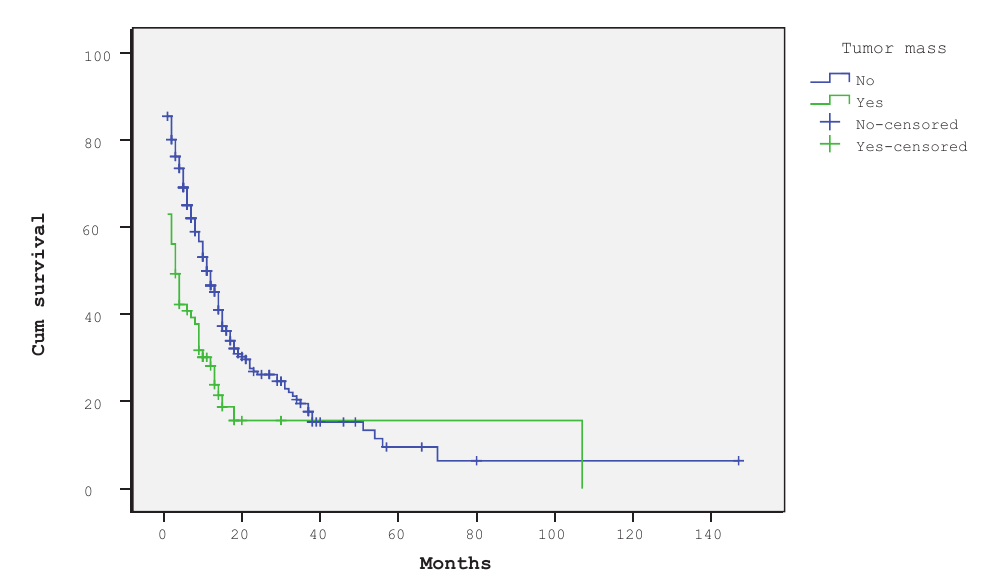
Figure 2 - Survival curves of patients with or without a tumor